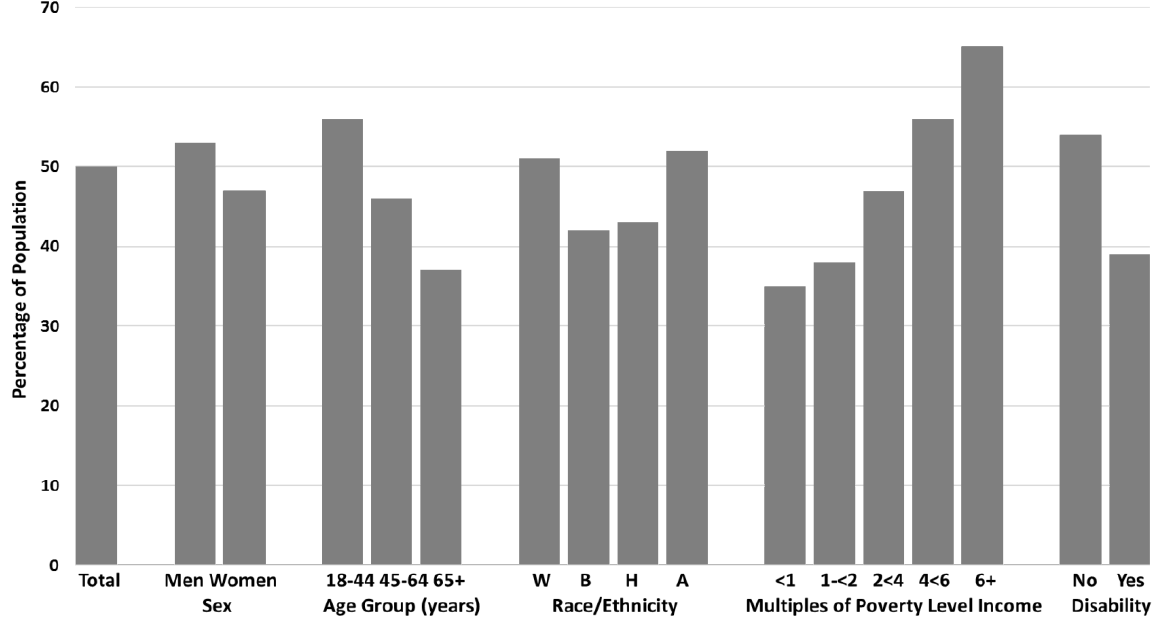
Figure C-4. Percentage Adults within or above Target Range for Moderate-to-Vigorous Physical Activity by Population Subgroup,